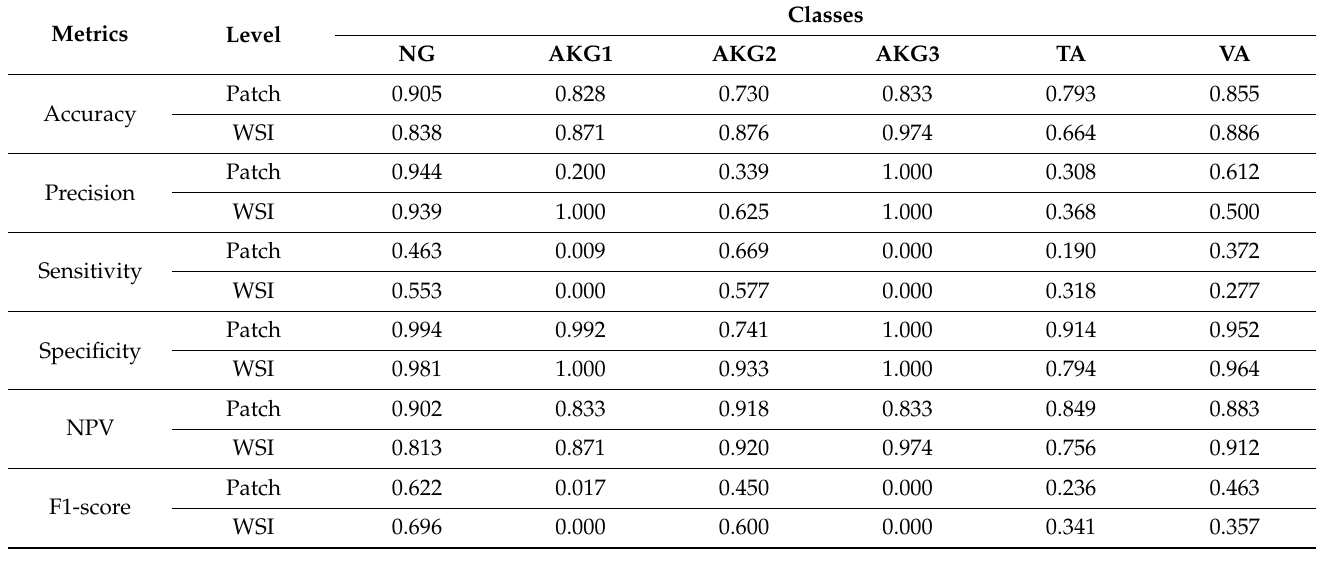
Table 5. Metric values for EfficientNet-b4 predictions. Patch-level evaluation corresponds to the WSI level in a way similar to the micro-averaging corresponding to the macro-averaging.